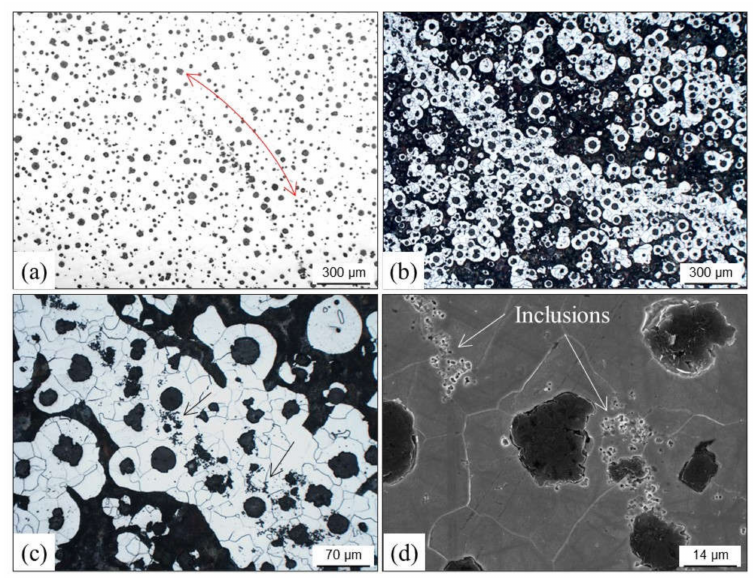
Figure 84. Examples of graphite nodules alignments in ( a ) an unetched sample and ( b ) a sample etched with Nital reactant. Optical ( c ) and SEM ( d ) images of small inclusions found in the area of graphite alignment.